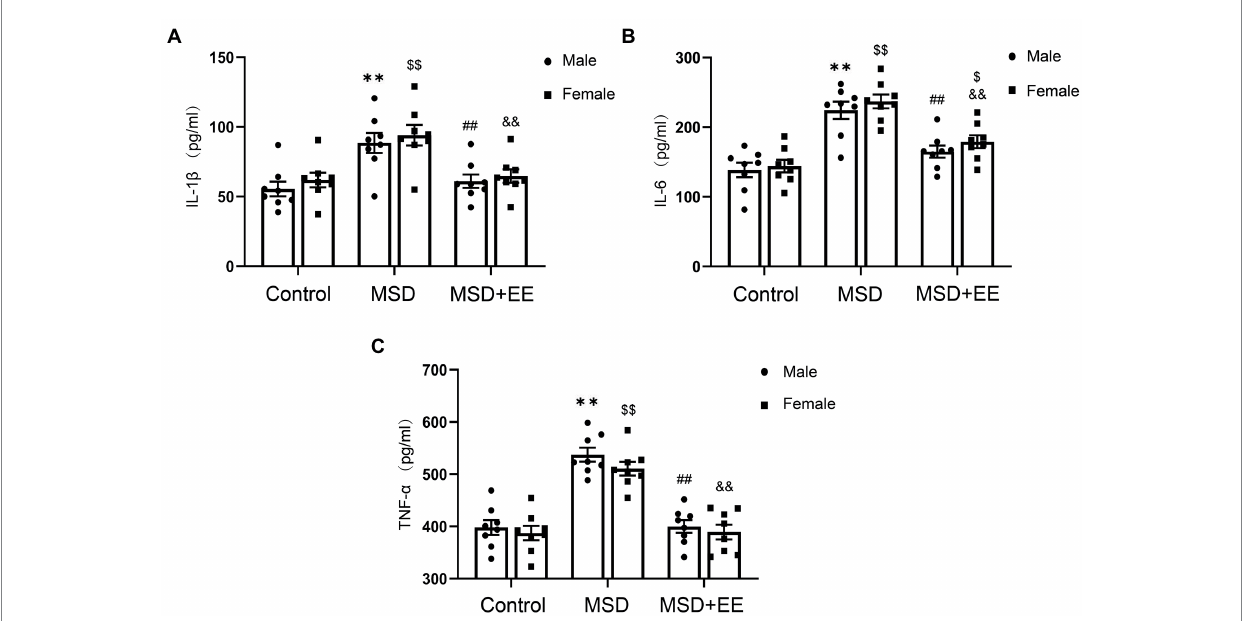
FIGURE 4 Effects of an environmental enrichment (EE) on inflammation mediators in the hippocampus of elderly offspring mice exposed to maternal sleep deprivation (MSD). (A) Expression level of IL-1 β in the hippocampus. (B) Expression level of IL-6 in the hippocampus. (C) Expression level of TNF- α in the hippocampus. ** p < 0.01 vs. Control group in males; $ p < 0.05, $$ p < 0.01 vs. Control group in females; ## p < 0.01 vs. MSD group in males; && p < 0.01 vs. MSD group in